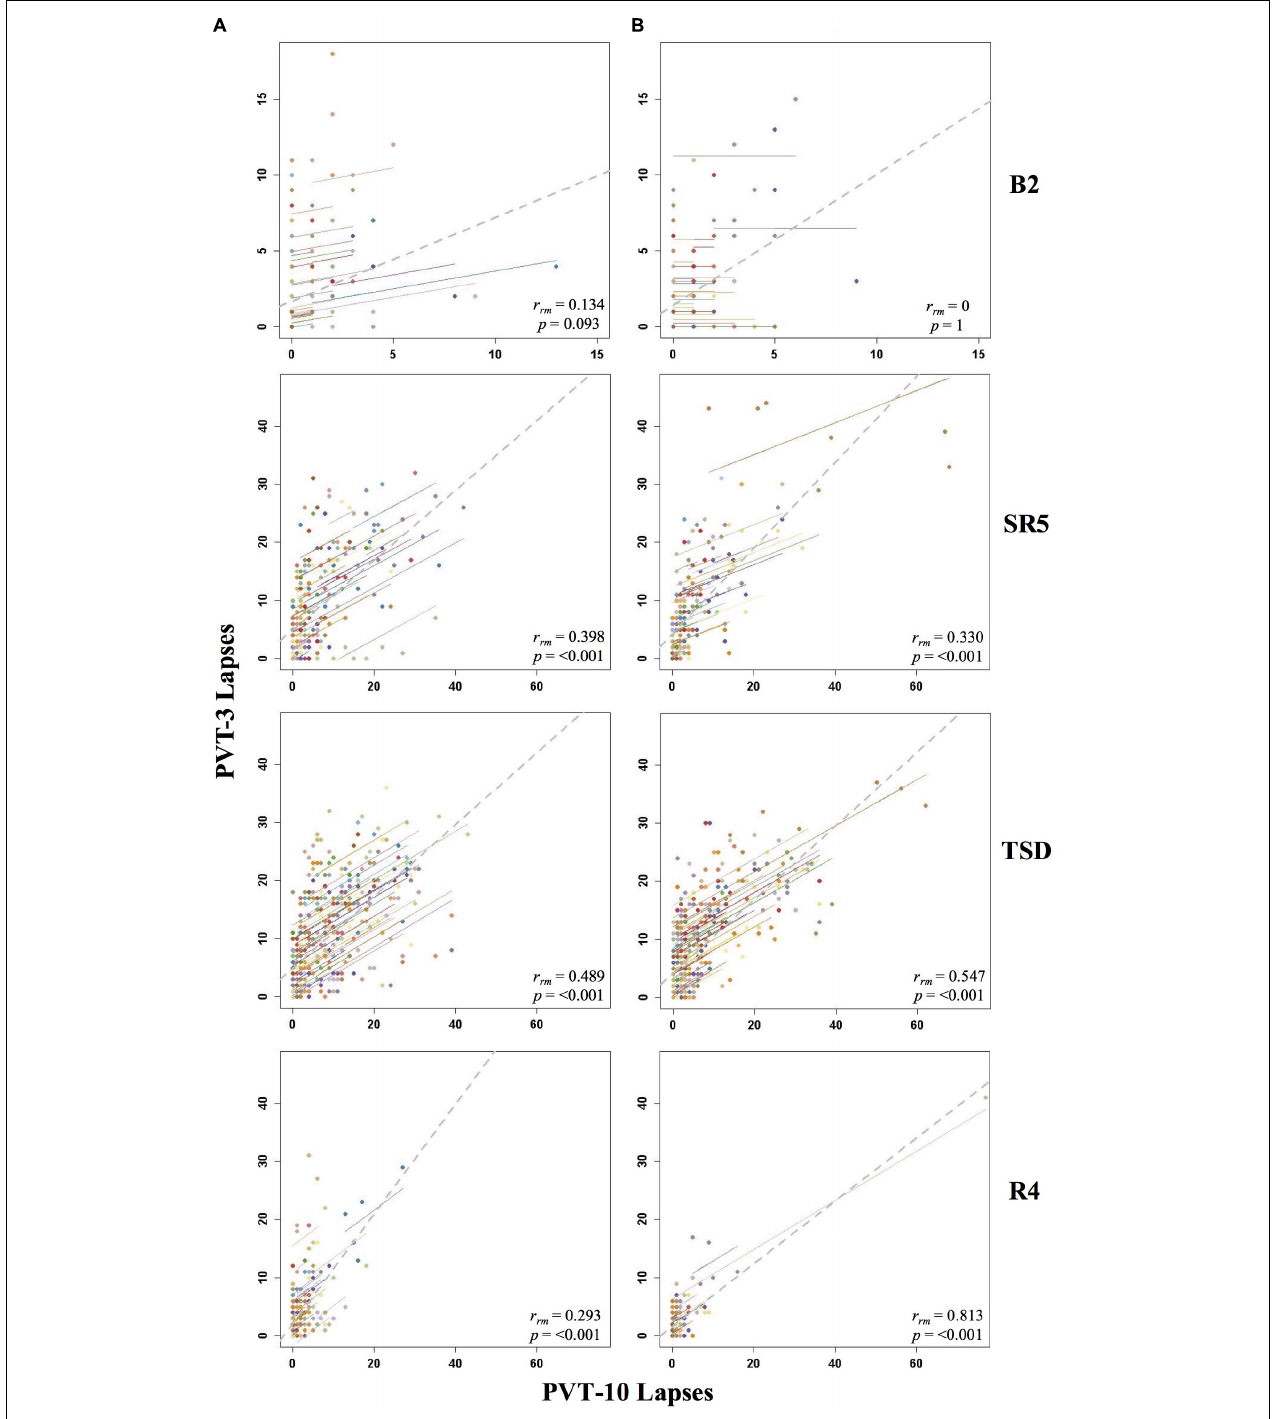
FIGURE 2 | Rmcorr plots of repeated-measures correlations between 10-min Psychomotor Vigilance Test (PVT-10) and 3-min Psychomotor Vigilance Test (PVT-3) lapses by study day for Condition A (A) and Condition B (B) . Each color represents a distinct participant with each point showing performance on both measures at one time point while the corresponding line shows the rmcorr fit for that participant (Bakdash and Marusich, 2020; R Core Team, 2020). The gray dashed line represents the regression line obtained by ignoring repeated measurements and treating the data as independent observations; r rm represents the common within-individual association (rmcorr). Rmcorr effect sizes were interpreted as follows: 0.00–0.29, negligible; 0.30–0.49, weak; 0.50–0.69, moderate; 0.70–0.89, strong; and 0.90–1.00, very strong. Included time points for each day were as follows: baseline day 2 (B2) from 1000 to 2200 h; sleep restriction day 5 (SR5) from 0800 to 2000 h; total sleep deprivation (TSD) from 2200 to 2000 h; and recovery day 4 (R4) from 1000 to 2000 h.